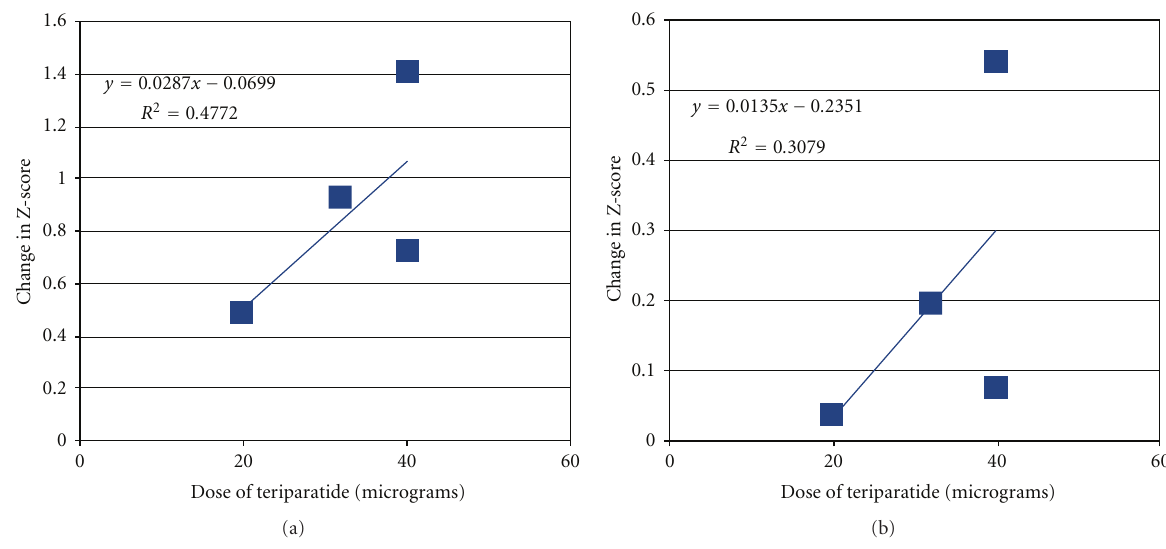
Figure 1: Increase in spine (a) and femur (b) BMD in the Teriparatide studies by daily